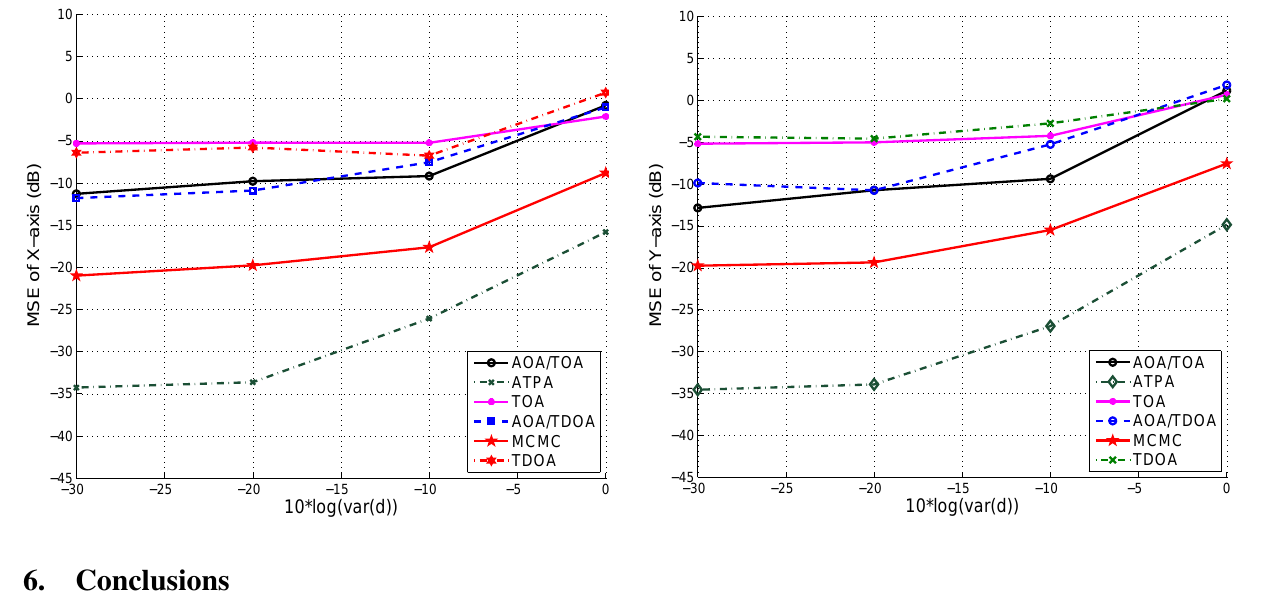
Figure 19. The effect of mobility on position estimation (using AOA/TOA information); position error of x (left) and position error of y-axis